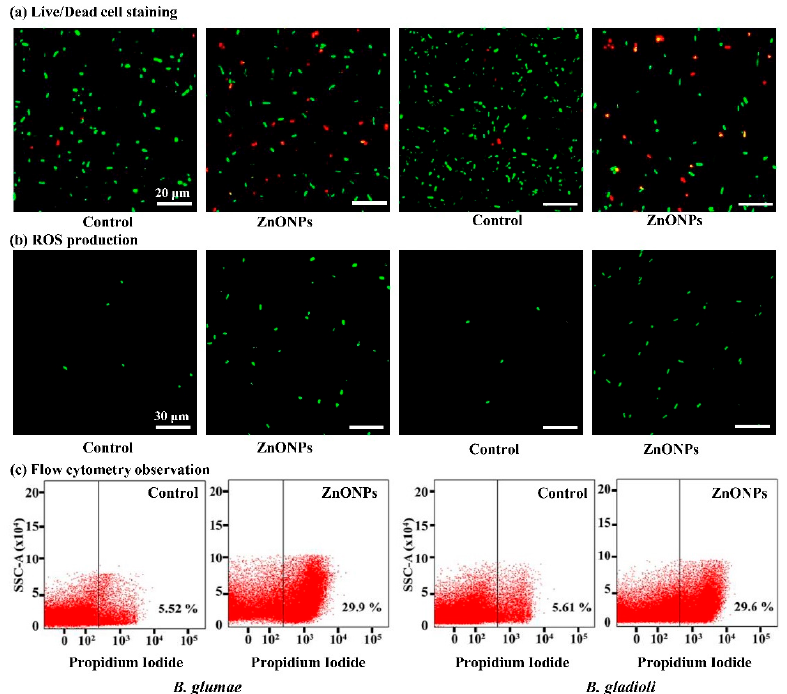
Figure 6. Antibacterial potential of biogenic ZnONPs against B. glumae and B. gladioli cells after 8 h treatment with (50 µ g mL − 1 ) and without (control) biogenic ZnONPs. ( a ) Live/dead cell staining, with green fluorescence representing the live bacteria, while red fluorescence presents dead bacteria (scale bar = 20 µ m]. ( b ) Formation of reactive oxygen species (ROS) in B. glumae and B. gladioli cells. ( c ) Flow cytometry images of B. glumae and B. gladioli